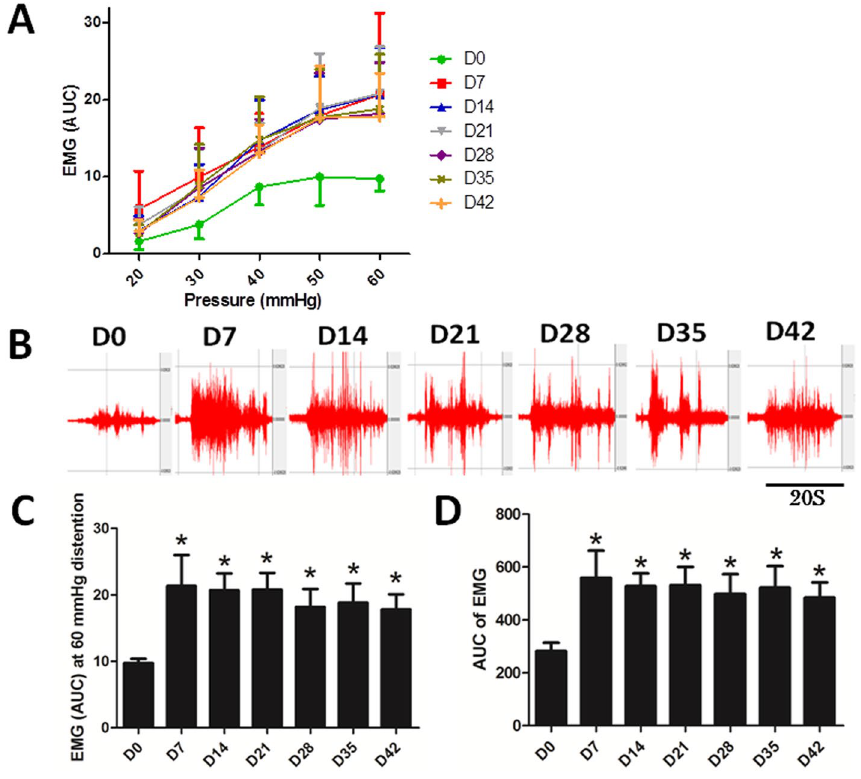
Figure 4. Abdominal EMG responses to colorectal distention in DSS-induced colitis rats. ( A ) The EMGs at different distention pressures and different time points. ( B ) Original EMG tracings at a colorectal distention pressure of 60 mmHg on different days in a typical rat. ( C ) The area under the curve (AUC) of the EMG at a distention pressure of 60 mmHg on different days. ( D ) The area under the curve (AUC) of the EMG summed at all distention pressures on different days. * P < 0.05 compared with Day 0. (N = 8).